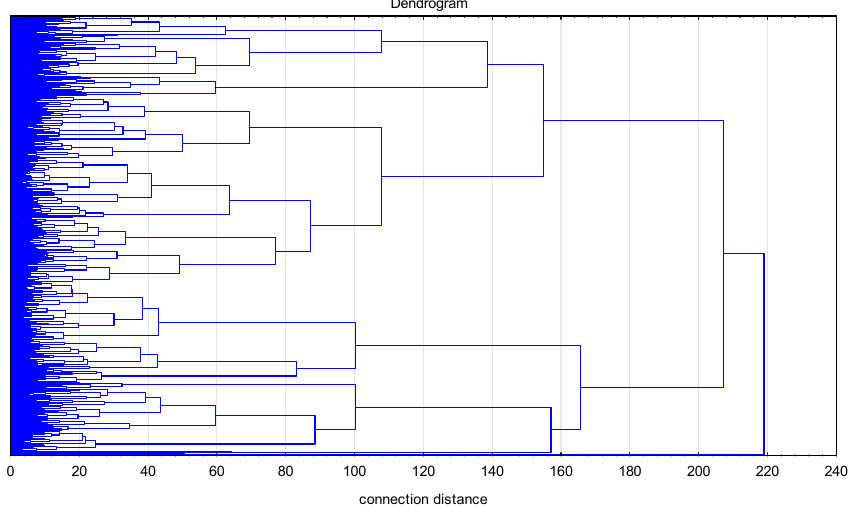
Figure 4. Dendrogram of the hierarchical clustering.